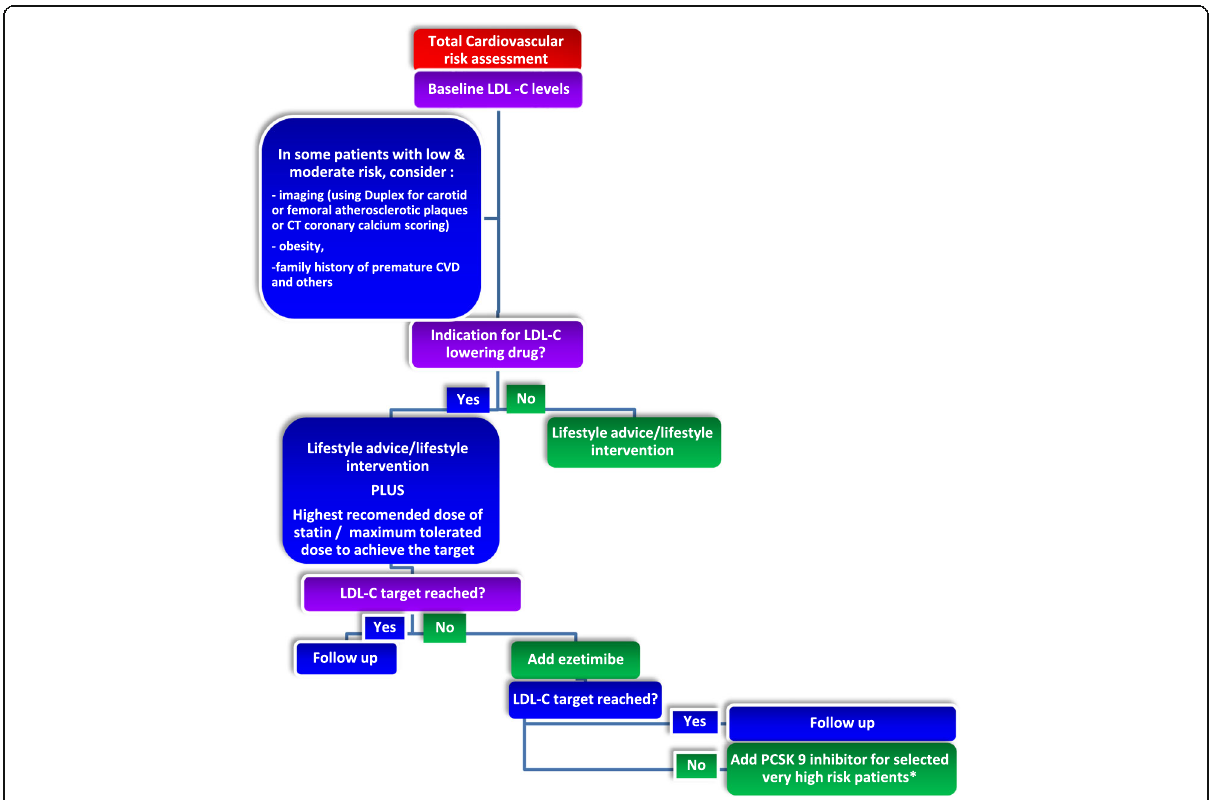
Fig. 2 Treatment algorithm for LDL-C lowering. *Add PCSK9 inhibitor for secondary prevention in very-high-risk patients and for primary prevention in patients with FH and another major risk factor (very high risk). *Consider adding PCSK9 inhibitor for primary prevention patients at very high risk, but without